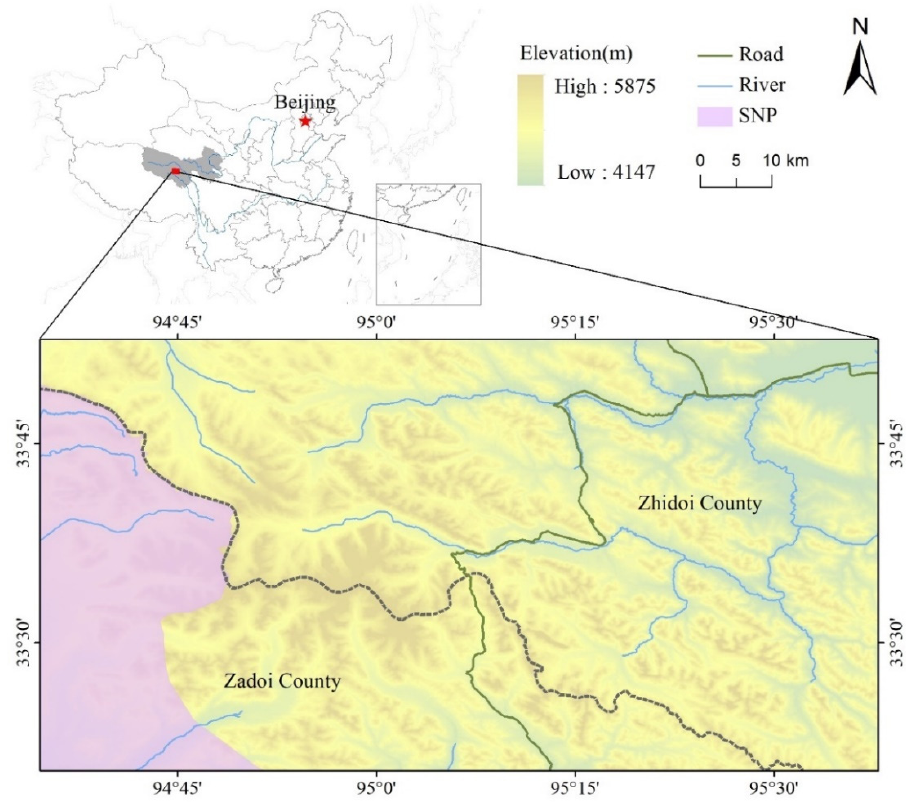
Figure 1. The case study area (Sobchaye).